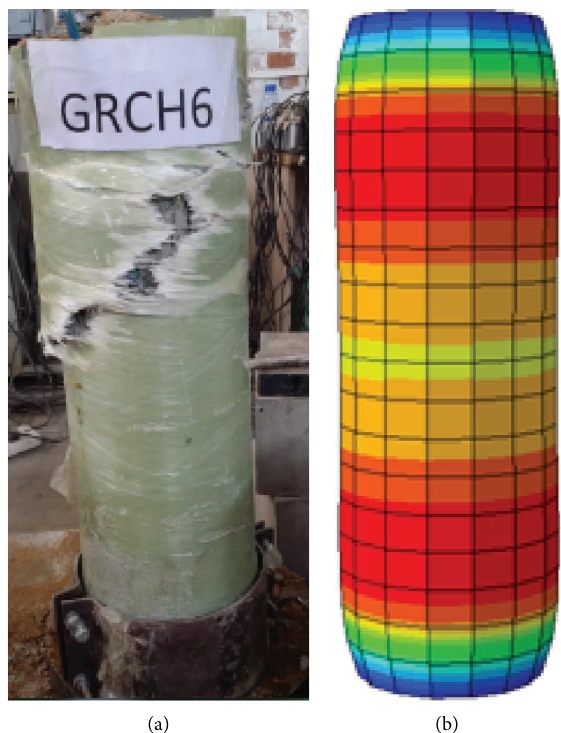
Figure 8: Test and simulated failure mode. (a) Failure mode of GRCH6 in [30]. (b) Simulation results.